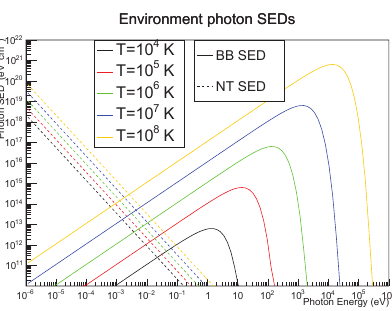
Figure 1. Thermal (continuous lines) and non-thermal (dashed lines) photon SEDs considered in this work at di ff erent black body temperatures (from yellow 10 8 K to black 10 4